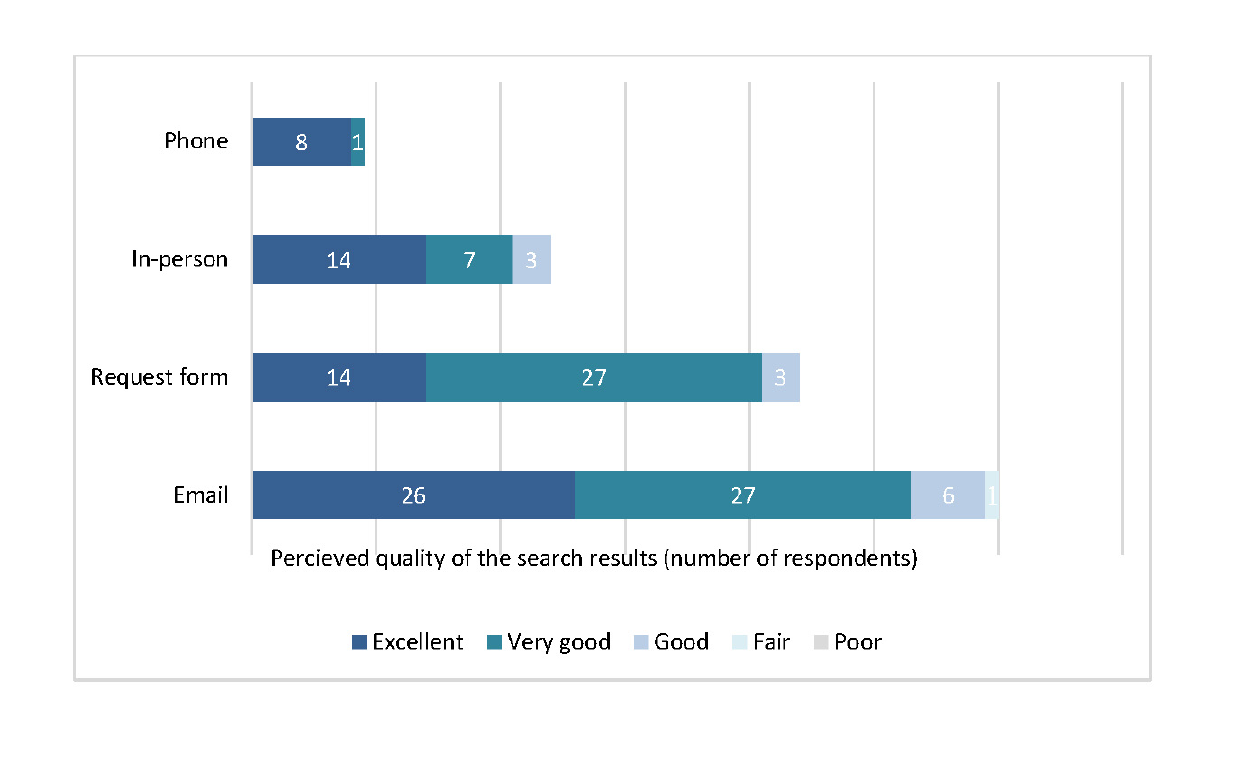
Figure 3 Perceived quality of the search results by method of submitting the search